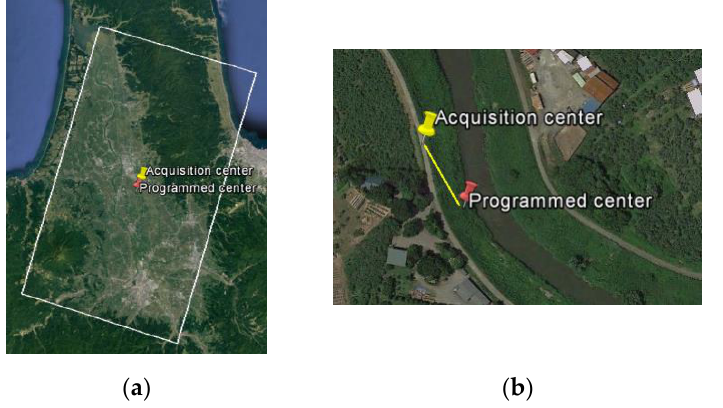
Figure 19. ( a ) A VEN μ S site footprint with the centers; ( b ) zoom on the distance between programmed and acquired image center.